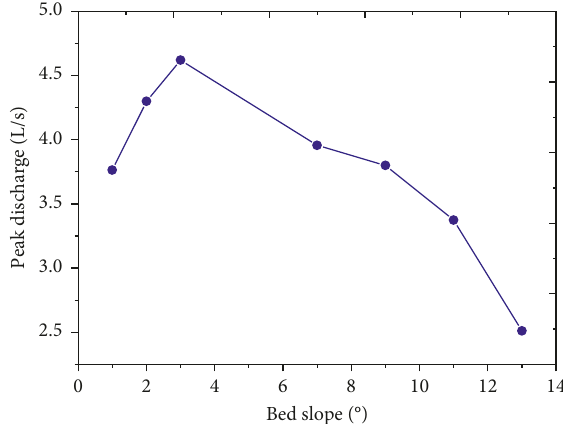
Figure 6: The relationship between peak discharges and bed